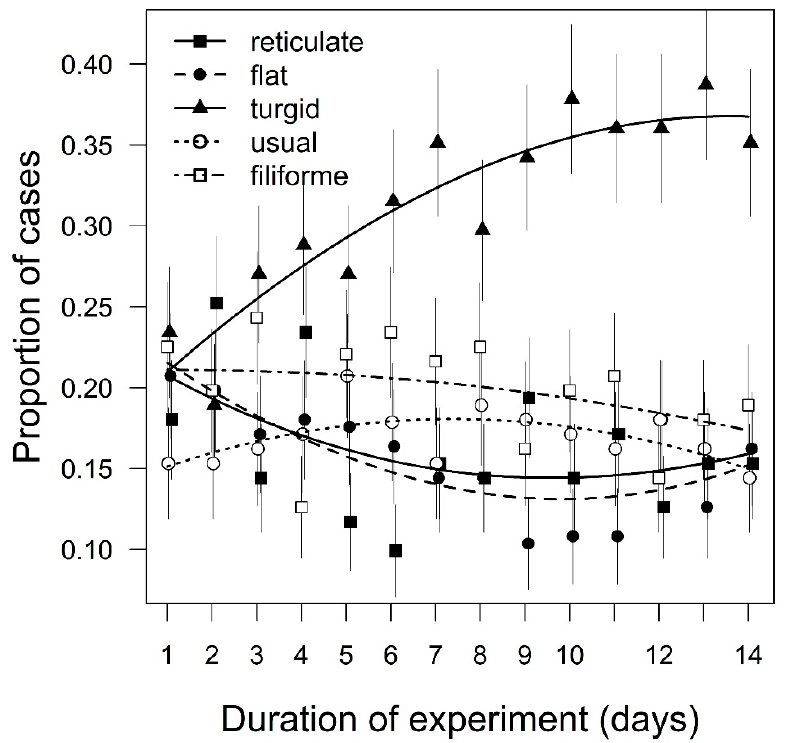
Figure 4. Proportion of the cases when beetles chose moss morphotypes ( reticulate, flat, turgid, usual, filiforme ) with removed spatial structures on each day of the experiment (mean ± standard error, the trends are based on loess). The differences in proportion of cases when beetles chose a particular morphotype were tested by generalized estimating equation models with binomial